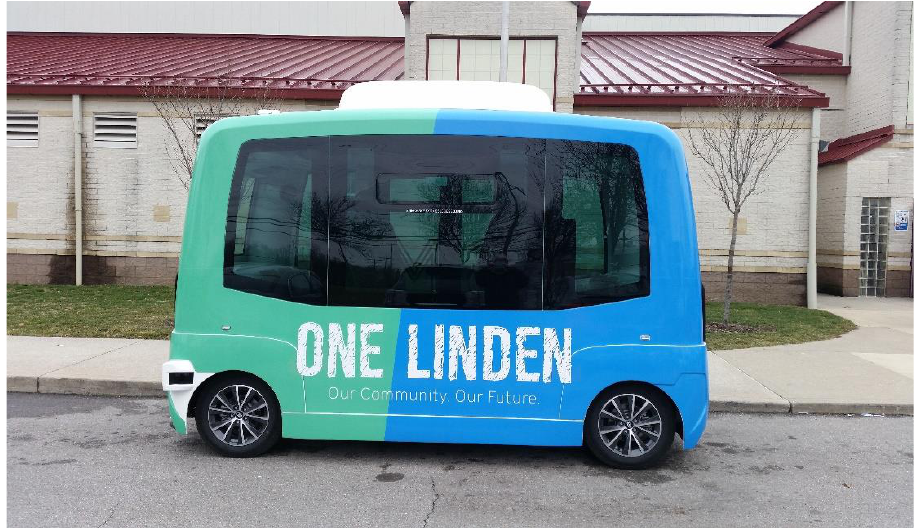
Figure 8. EasyMile Shuttle.